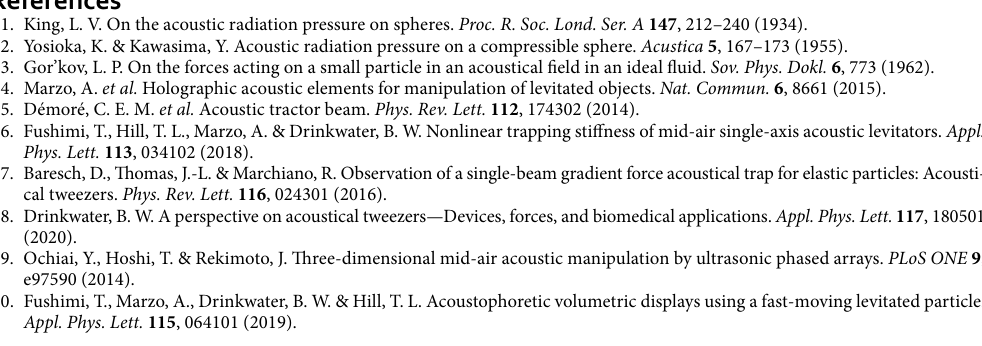
Figure 7a,b illustrate the measurement setup for the microfluidic channel. Our microfluidic channels (depth = 180 µ m, width = 6.41 mm, and length = 32 mm) were manufactured using the standard semiconductor fabrication process. A silicon wafer of 500 µ m was etched by the deep reactive ion etching. Following this, the top-side of the silicon wafer was sealed with a glass plate of 700 µ m thickness via anodic bonding. The wafer was subsequently diced into small chips, the glass plate was drilled, and the silicon tubes were glued to both edges of the channel. In the next step, piezoelectric transducers (HC-2015S12, Honda Electronics Co., Ltd.) were attached to both the longer sides of the chip, and water containing the small particles was filled in the channel using a piezoelectric micropump (SDMP302, Takasago Fluidic Systems). We used particles of diameter 10.57 µ m with 0.11 µ m standard deviation (PS-ST-10.6, Microparticles GmbH) at a concentration of 0.05% w/v. To mimic the ultrasounds emitted from the multiple sources, we applied the synthesized multitone voltage 6 V n sin (ω n t + η n ) to the piezoelectric elements using an arbitrary waveform generator (Mi2.6021, SPEC- n = 1 TRUM) with control software (SBench6-Pro 6.1). Thus, the synthesized field was induced in the microfluidic (cid:31) chip. The driving frequency was ω n = ω 0 + ( n − 1 )δω with ω 0 /( 2 π) = 117 kHz and δω/( 2 π) = 0.25 Hz. The power of the waveform generator was amplified with a power amplifier (HSA 2011, NF Corp.). The peak-to-peak voltage at the amplifier output was 40 V. The trajectory of the particles was recorded using an optical microscope (SMZ-10, Nikon Corp.) equipped with a CMOS camera (WRA YCA M-NOA630, WRAYMER Inc.) at a capture rate of 1 Hz. It must also be noted that the channel width was approximately matched to the half-wavelength to create a one-dimensional resonant standing wave.